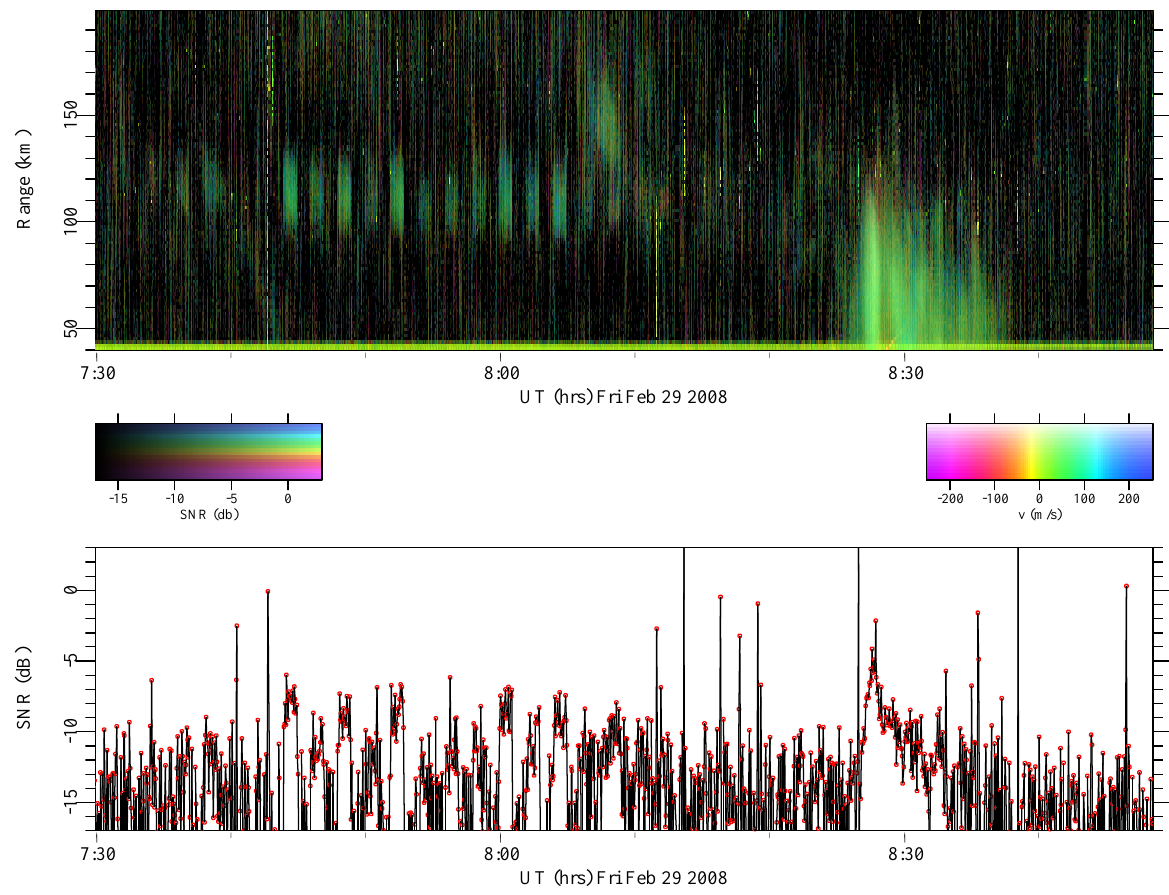
Fig. 3. RTDI plot of backscatter from artificial E region FAIs over HAARP observed on February 29, 2008, during a sporadic E layer event. Natural auroral echoes are evident in apparent ranges outside the 90–140 km interval.The incoherent integration time for the figure is about 13 s.